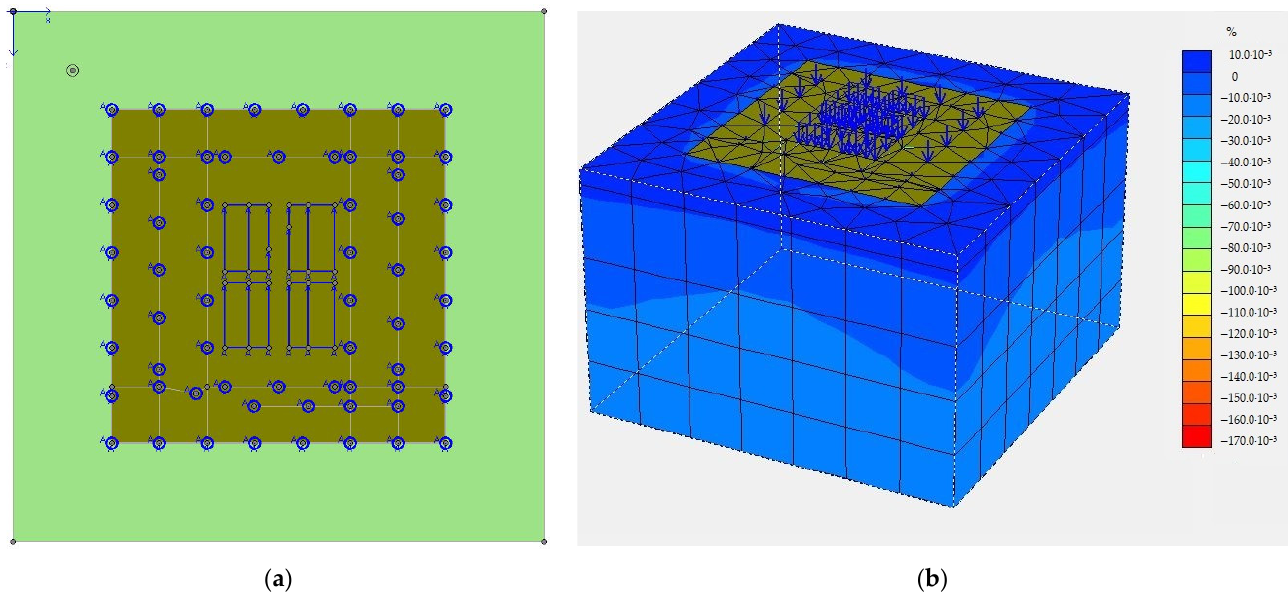
Figure 14. Numerical modeling in Plaxis 3D: ( a ) loading scheme; ( b ) volumetric strains.